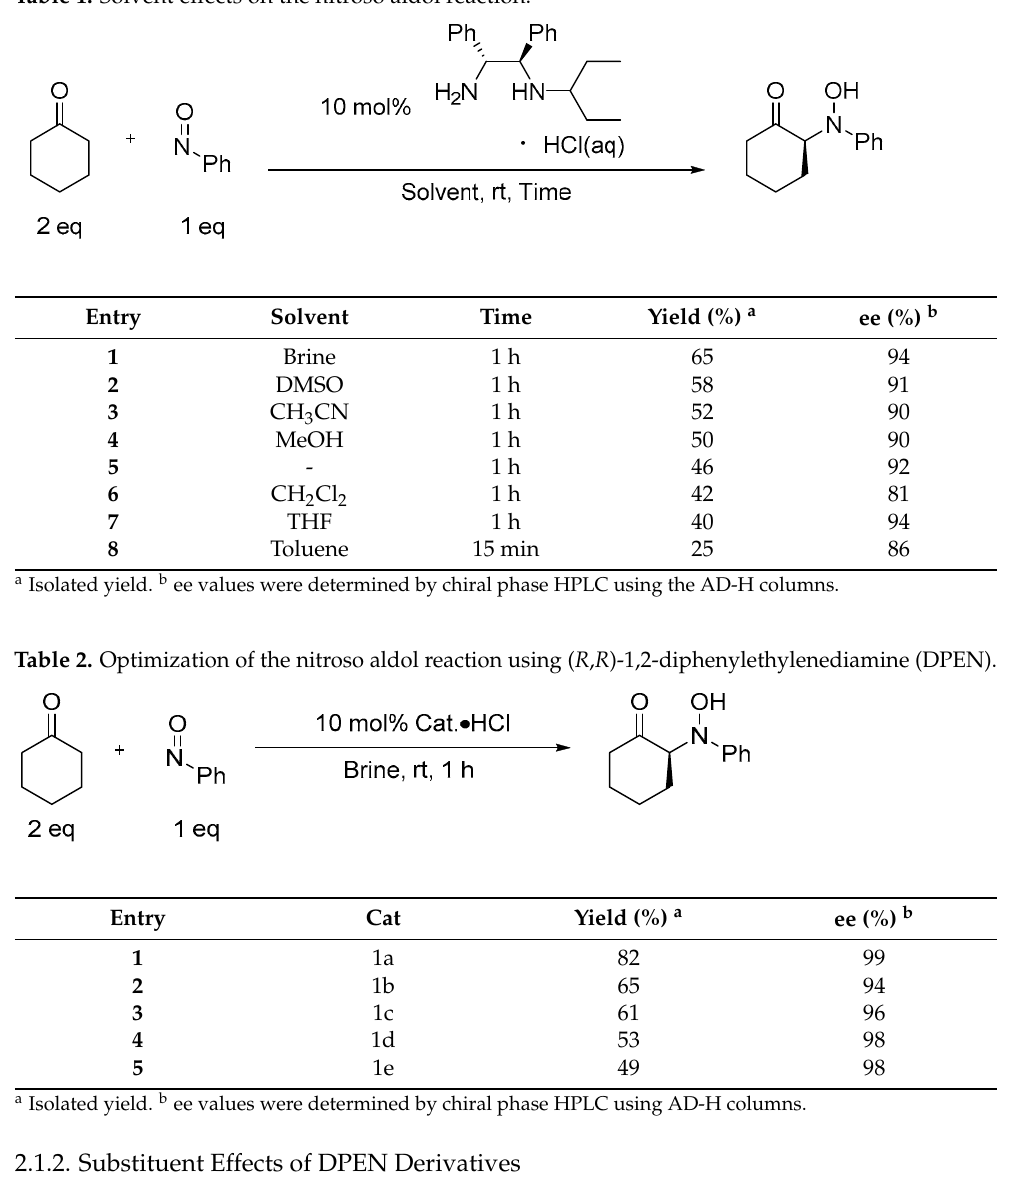
Figure 2. Chiral 1,2-diamine catalysts prepared for use in this study.